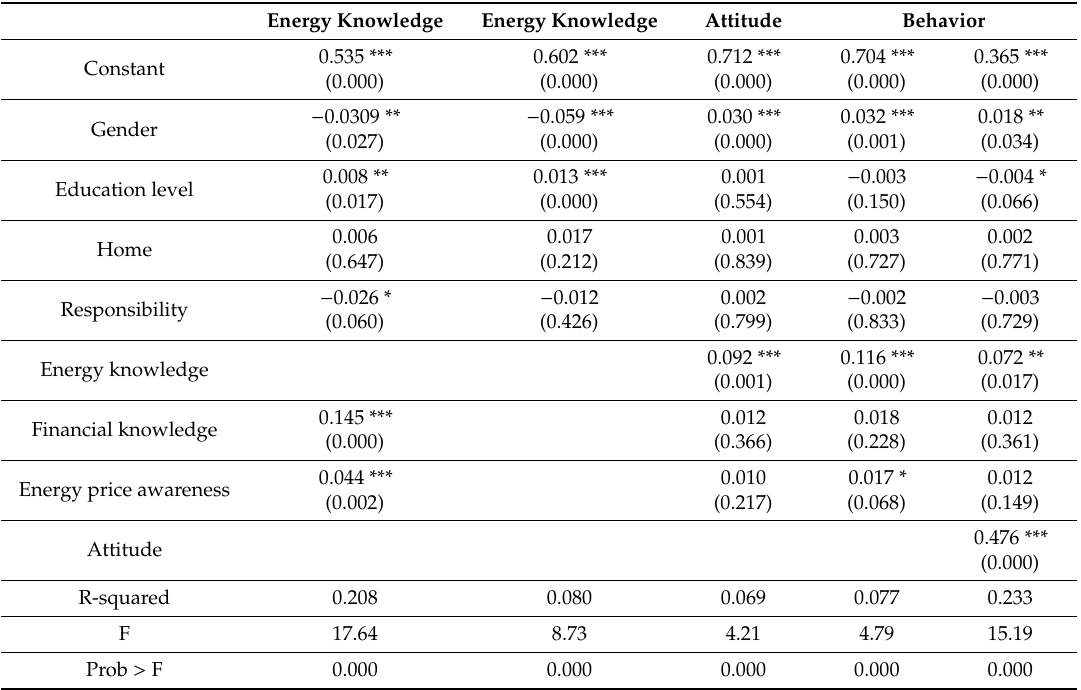
OLS estimation results for energy literacy dimensions—knowledge, attitude and behavior—using di ff erent